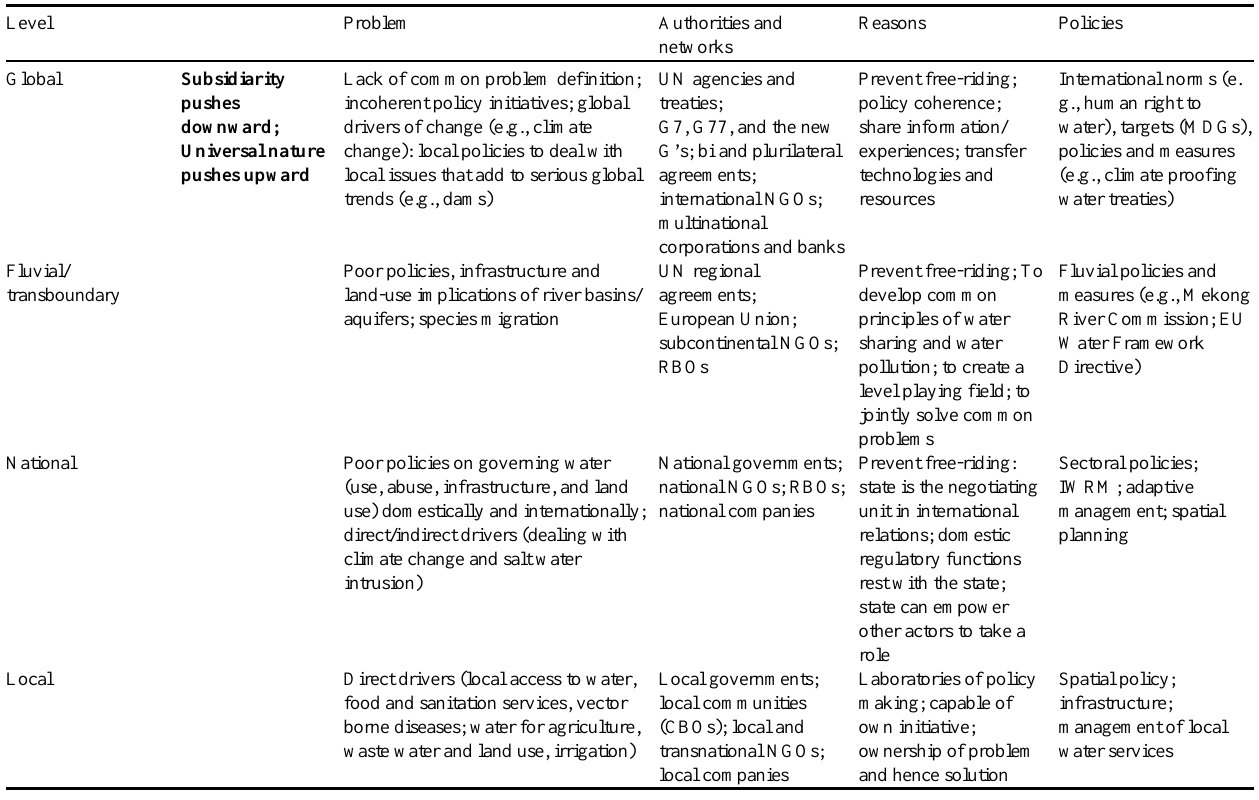
Table 2 . Examples of different problems and policy options for different levels. IWRM = integrated water resource management, RBOs = river basin organizations, CBO = community-based